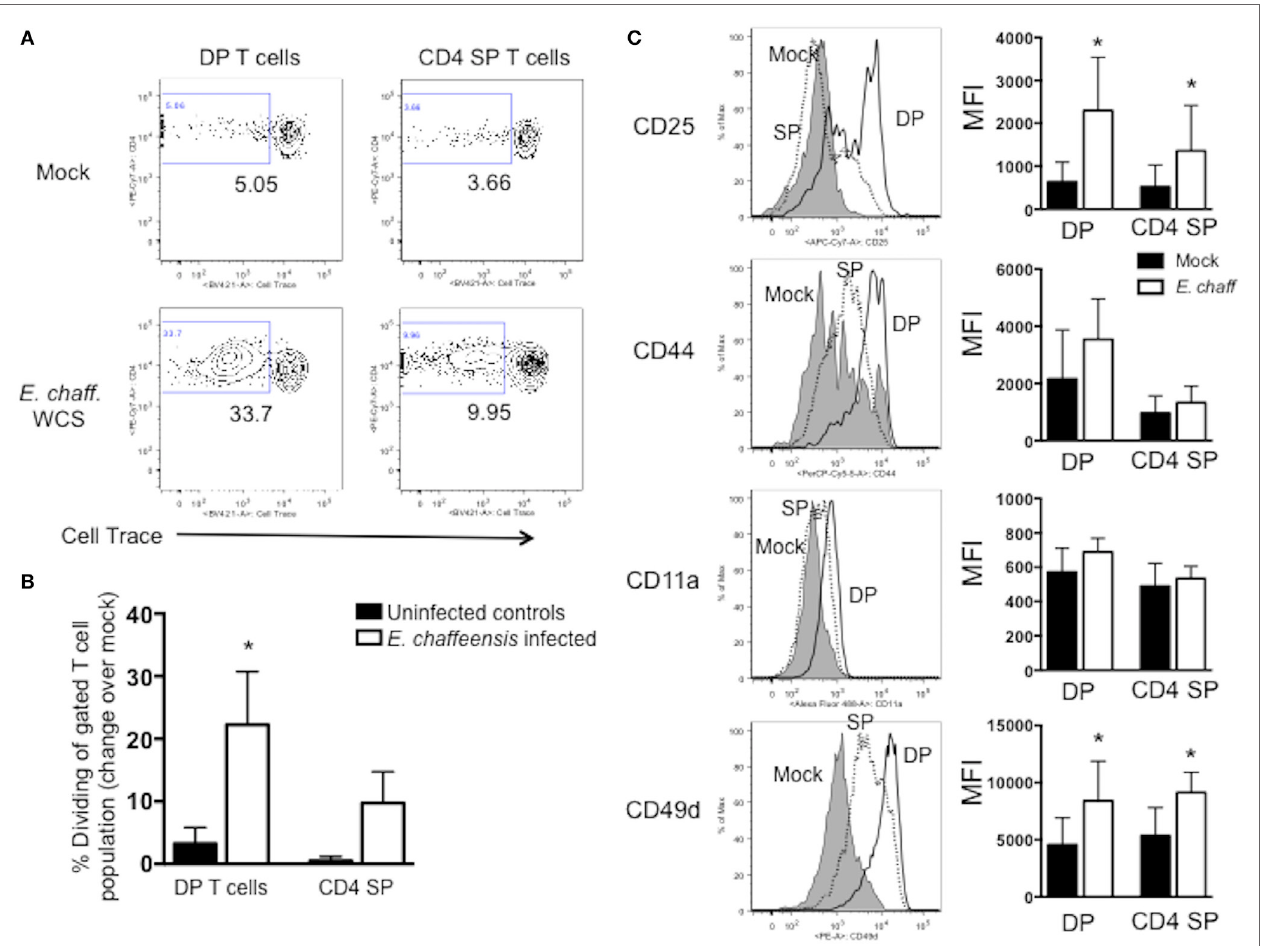
FigUre 4 | CD4 + CD8 + double-positive (DP) T cells from Ehrlichia chaffeensis infected dogs proliferate and upregulate activation markers in specific response to E. chaffeensis antigen. On day 25 post-infection peripheral blood mononuclear cells were isolated from control, uninfected dogs and E. chaffeensis infected dogs in groups 1–3 as shown in Figure 2 . Cells were labeled with Cell Trace Violet and stimulated for 5 days with 10 µg/ml E. chaffeensis lysate as in Figure 2 . Mock- stimulated samples were used to correct for background proliferation. On day 5, antigen-specific CD3 + CD4 + CD8 + DP T cell and CD3 + CD4 + SP T cell proliferation assessed by flow cytometry. Representative flow plots are shown in (a) and aggregate results are shown in (B) . Data represent mean ± SEM. * p < 0.05 compared to uninfected controls (group 3) as determined by one-way ANOVA with Tukey’s post-test. (c) After 5 days of stimulation with E. chaffeensis antigen as in (a,B) , CD3 + CD4 + CD8 + DP T cells and CD3 + CD4 + single-positive (SP) T cells were analyzed for surface expression of CD25, CD44, CD11a, and CD49d. The left panel depicts representative flow plots from a single dog infected with E. chaffeensis , gated on live, CD3 + CD4 + CD8 + DP T cells. Gray histograms depict mock-stimulated DP T cells. Dotted histograms represent E. chaffeensis -stimulated CD4 SP T cells. Open histograms represent E. chaffeensis stimulated cells. The right panel depicts the mean fluorescence intensity (MFI) for each marker. The graphs represent aggregate results from n = 8 and are shown as mean ± SEM. * p < 0.05 compared to mock-stimulated cells of the same type, as determined by one-way ANOVA with Tukey’s